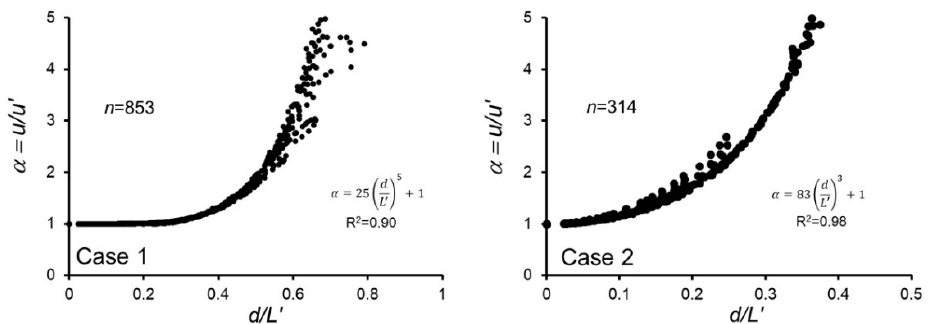
Figure 13. Relation between d and α in Cases 1 and 2. Table 3. Underestimation of nodule abundance due to burial. 1/ α represents the proportion of underestimation of the estimated abundance due to burial.